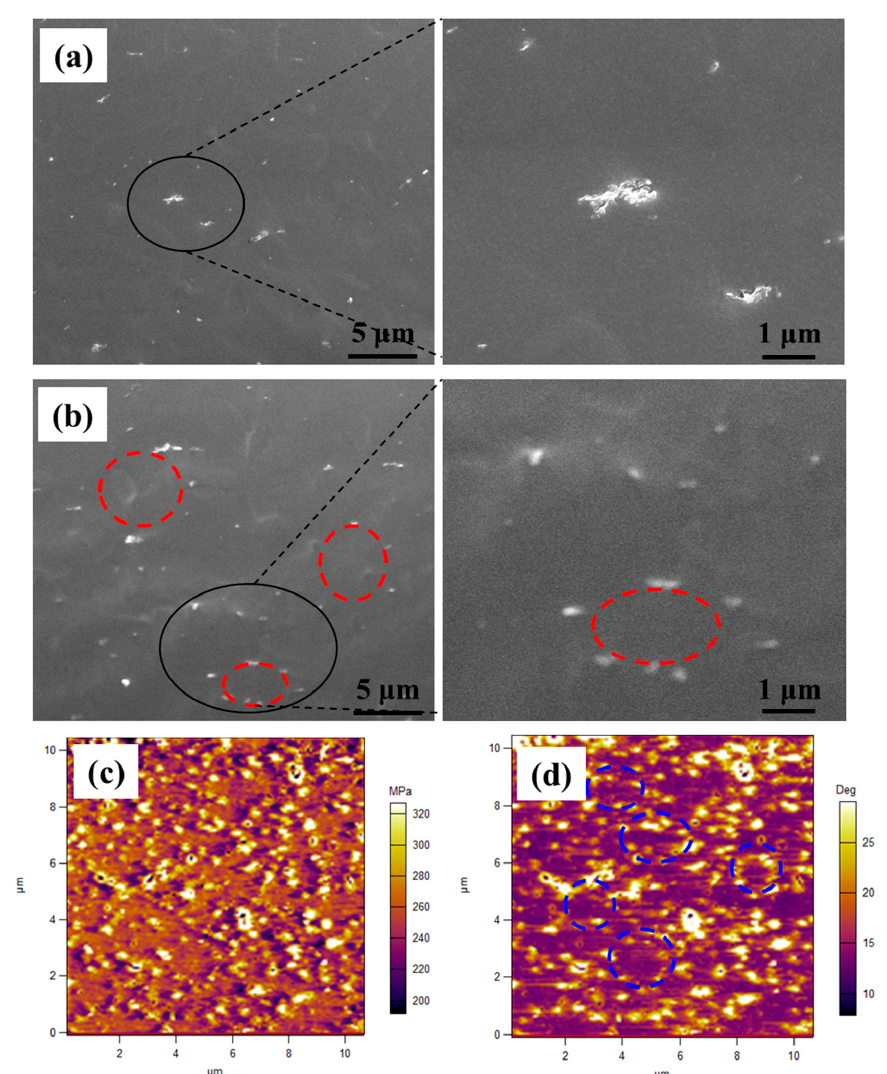
Figure 4. SEM images of ( a ) GNS/XNBR composite and ( b ) GNS-PDA/XNBR composite; AFM images with AM-FM viscoelastic mapping mode of GNS-PDA/XNBR composite: ( c ) moduli image and ( d ) phase image.